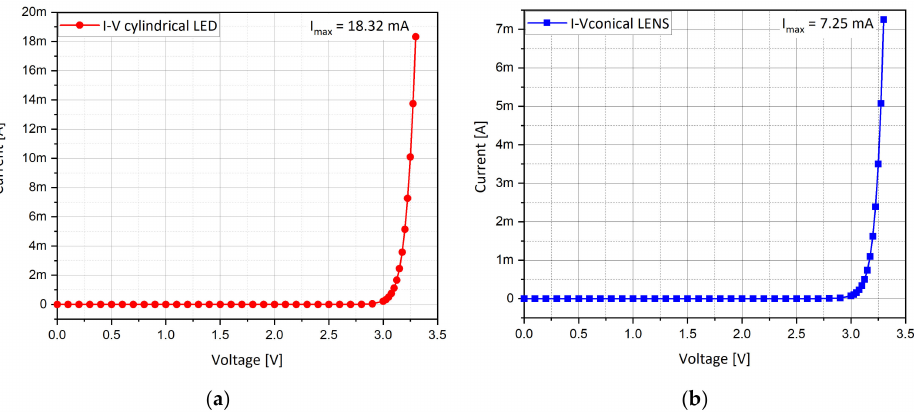
Figure 6. ( a ) I-V curve of cylindrical LED; ( b ) I-V curve of conical LENS. V = 3.3 V, λ = 450 nm, E gap = 2.75 eV.